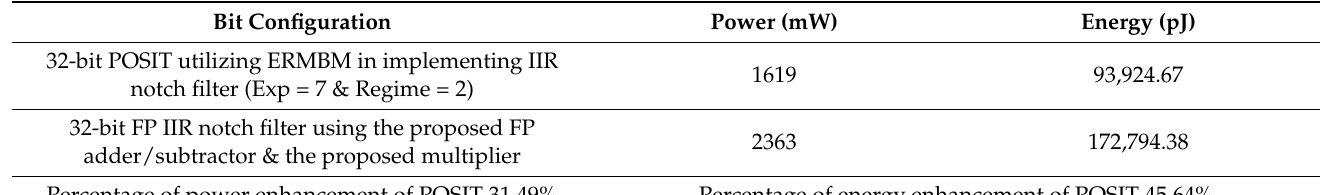
Table 11. Comparison of the power and energy between a 32-bit POSIT IIR notch filter utilizing an ERMBM and a 32-bit floating point second-order IIR notch